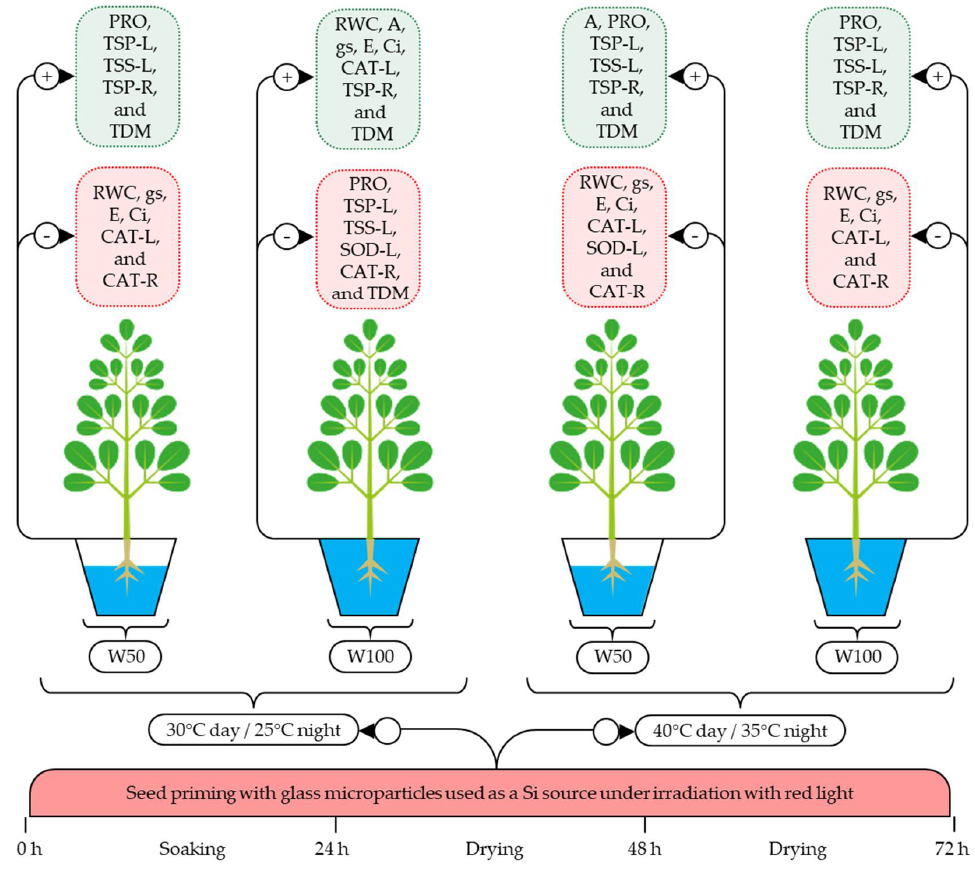
Figure 4. Effect of seed priming with SiMPs under red light irradiation on seedlings of Moringa oleifera subjected to thermal and water stress. RWC, relative water content; TDM, total dry matter; A, net photosynthetic rate; gs, stomatal conductance; E, transpiration; Ci, internal CO 2 concentration; PRO, proline; TSP-L, total soluble proteins in leaves; TSP-R, total soluble proteins in roots; TSS-L, total soluble sugars in leaves; SOD-L, superoxide dismutase in leaves; CAT-L, catalase in leaves; CAT-R, catalase in roots; W50, water stress; W100, no water stress. EL increased in the leaflets of M. oleifera seedlings subjected to heat and water stress when SP was not applied, which was also noted by [28], when they observed that water deficit (18 days without irrigation) induced an EL increase since the accumulation of reactive oxygen species (ROS) caused lipid peroxidation and rupture of the thylakoid membrane, thus limiting photosynthesis. However, in our study, there was a reduction in EL in M. oleifera seedlings subjected to thermal and water stress when SP was applied, which could be due to the role of SiMPs in modulating cell wall plasticity, leaf thickness, water-plant ratio, and plant metabolism and defense [29].